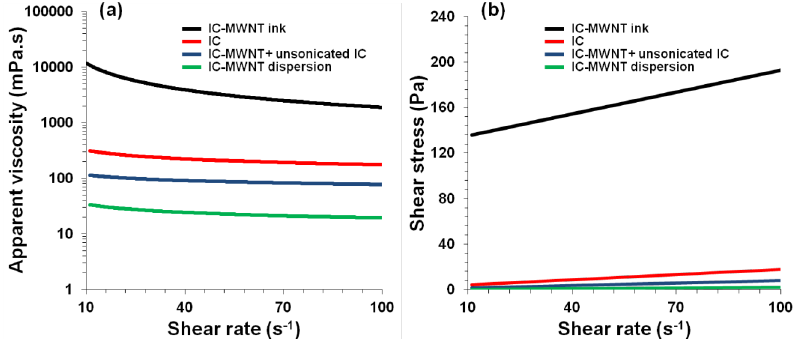
Figure 1. Flow curves for IC solution and IC-MWNT dispersions. ( a ) Apparent viscosity and ( b ) Shear stress as a function of shear rate for IC-MWNT ink after thickening process, IC solution (1.5% w / v ), IC-MWNT after addition of unsonicated biopolymer and IC-MWNT composite dispersion. Lines in ( a , b ) are fits to Equations (1) and (2), respectively. All samples were measured at 21 ◦ C.